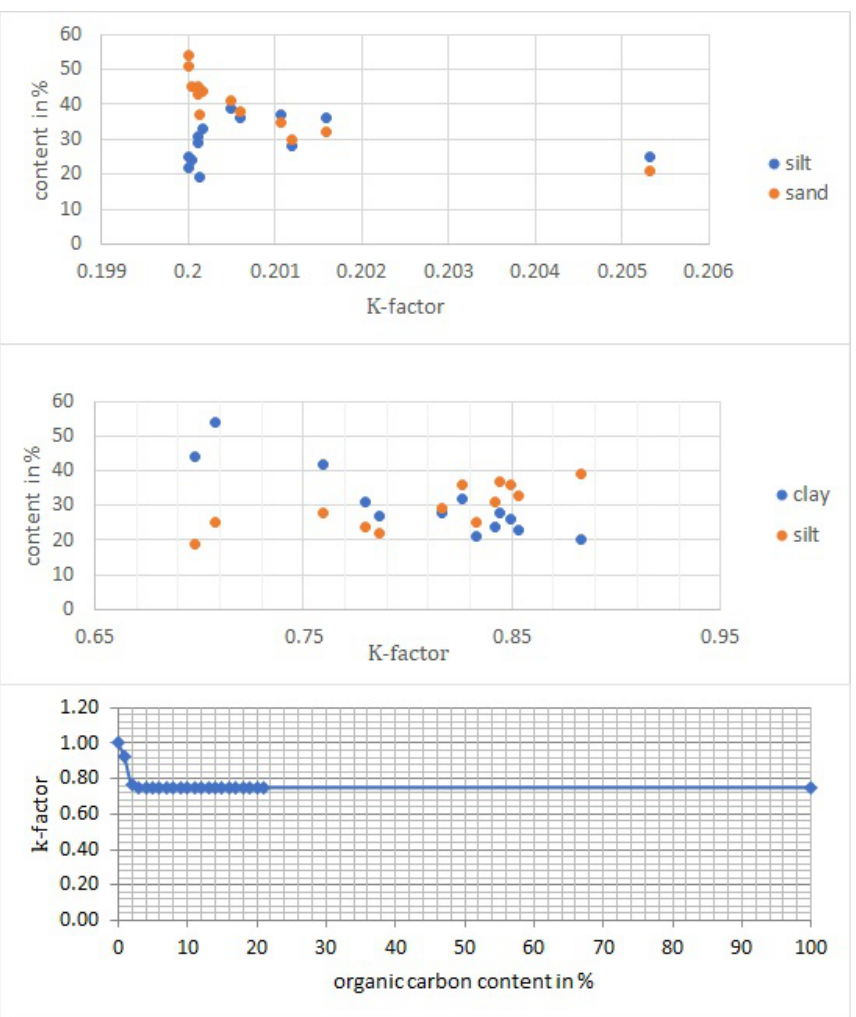
Figure 19. Comparison of sub- K -factors based on soil data, which represent any of the four water- sheds under our